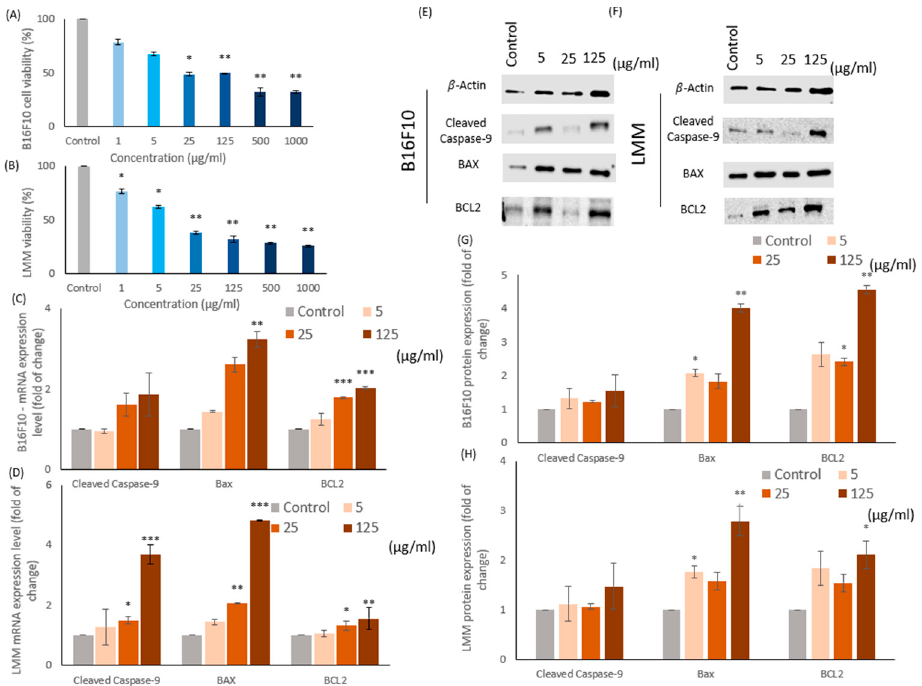
Figure 2. The cell viability of ( A ) B16F10 and ( B ) LMM was examined by MTT assay in different concentrations of CM. The mRNA levels of cleaved caspase-9, Bax, and BCL2 in ( C ) B16F10 and ( D ) LMM were tested after incubation in 5, 25, and 125 μ g/mL CM. Protein levels of cleaved caspase-9, Bax, and BCL2 in ( E ) B16F10 and ( F ) LMM were detected by Western blotting after 5, 25, and 125 μ g/mL CM were conducted. The protein quantity of cleaved caspase-9, Bax, and BCL2 in ( G ) B16F10 and ( H ) LMM were analyzed by ImageJ. * p < 0.05, ** p < 0.01, *** p < 0.005.